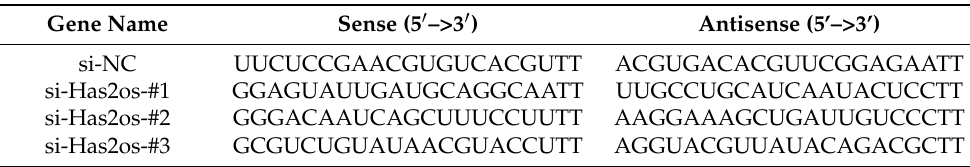
Table 2. Sequences of